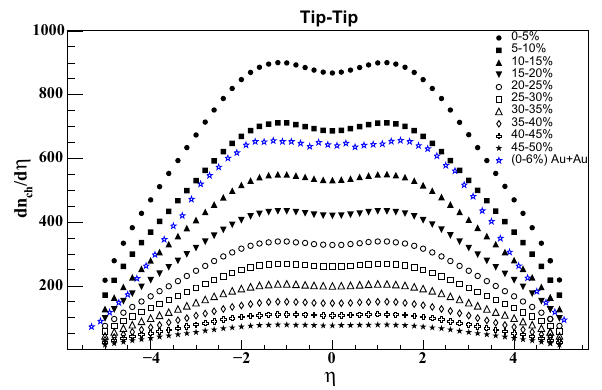
Fig. 9 Variation of dn ch / d η with respect to η is shown for tip–tip configuration of U + U collisions in different centrality class